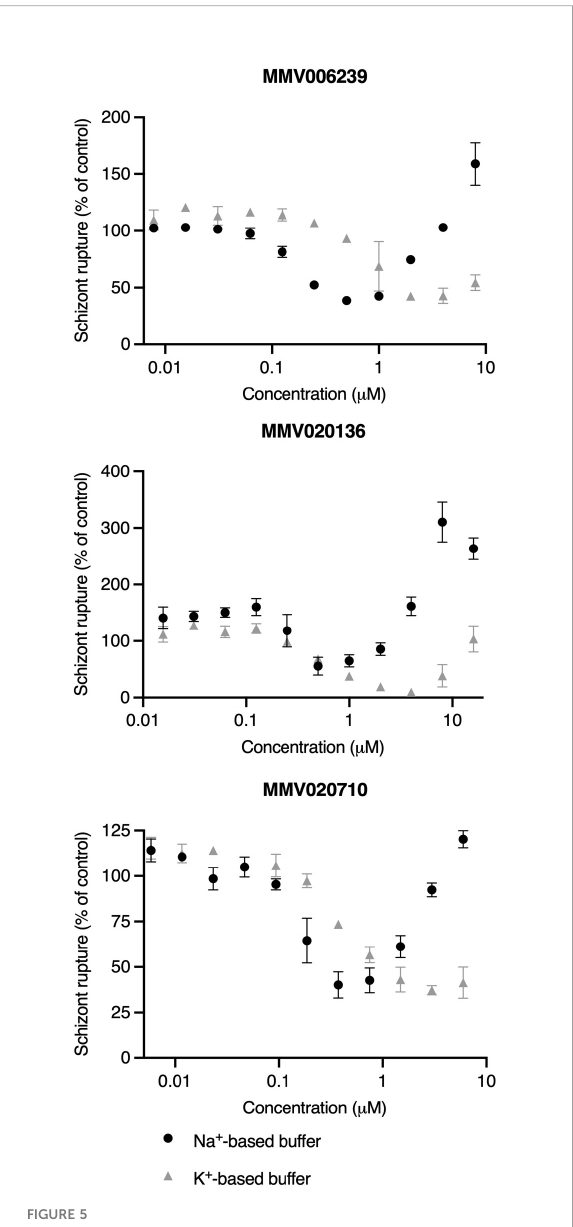
FIGURE 5 When administered to early/mid-stage schizonts, high concentrations of Pf ATP4 inhibitors promote nanoluciferase release in a Na + -dependent manner. Early/mid-stage schizonts (~36-40 hpi) that had not fully completed merozoite division were resuspended in a Na + -based buffer (black circles) or a Na + - depleted, K + -based buffer (grey triangles) and incubated with a 2-fold dilution series of Pf ATP4 inhibitors for 4 h. The bioluminescent signal intensity of nanoluciferase released into the buffer was then measured and values were normalised to the DMSO vehicle control. Lines and error bars indicate the mean ± SD of technical duplicates. Data obtained in a single experiment are shown as an illustrative example of those obtained in three independent experiments (Supplementary Figure